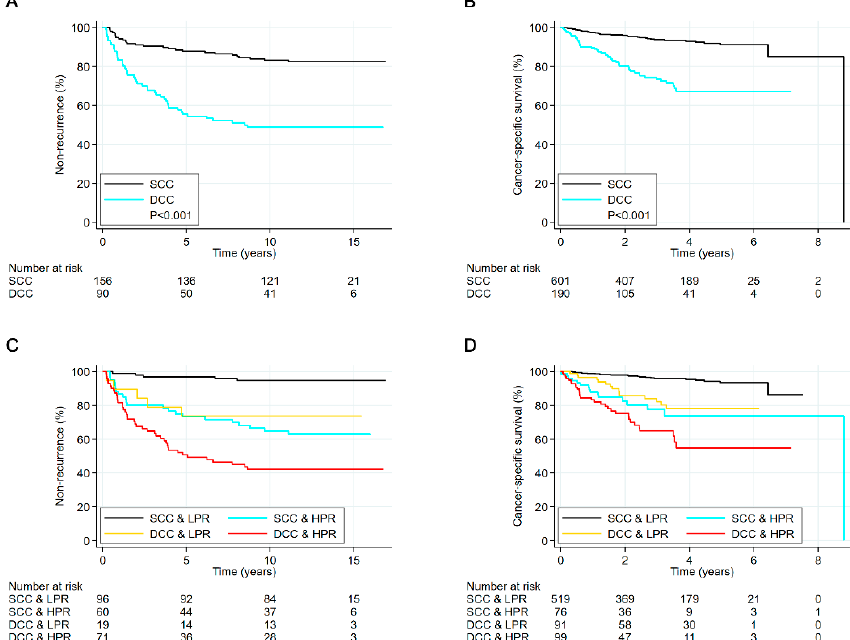
Figure 3. ( A ) Kaplan–Meier curves by marker of diversity of chromatin compartments in the ovarian carcinoma cohort. ( B ) Kaplan–Meier curves by marker of diversity of chromatin compartments in the endometrial carcinoma cohort. ( C ) Kaplan–Meier curves by marker of diversity of chromatin compartments and pathological risk classification in the ovarian carcinoma cohort.